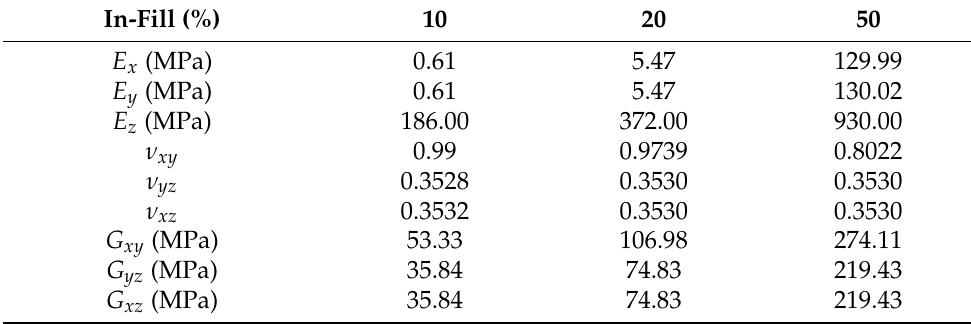
Table 4. ABS/PC properties for the homogenized in-fill